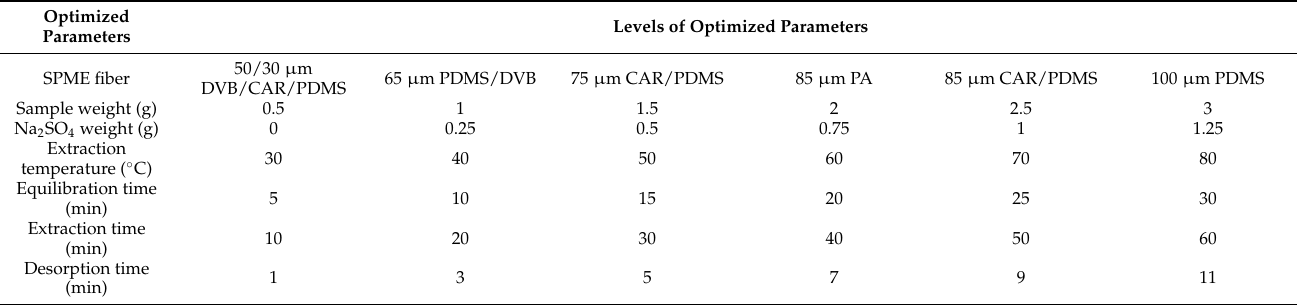
Table 3. The optimized parameters and levels of the HS-SPME